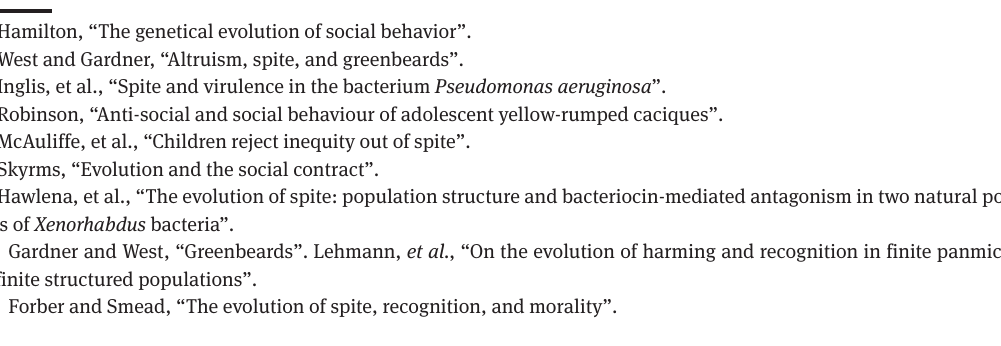
Actor/Recipient